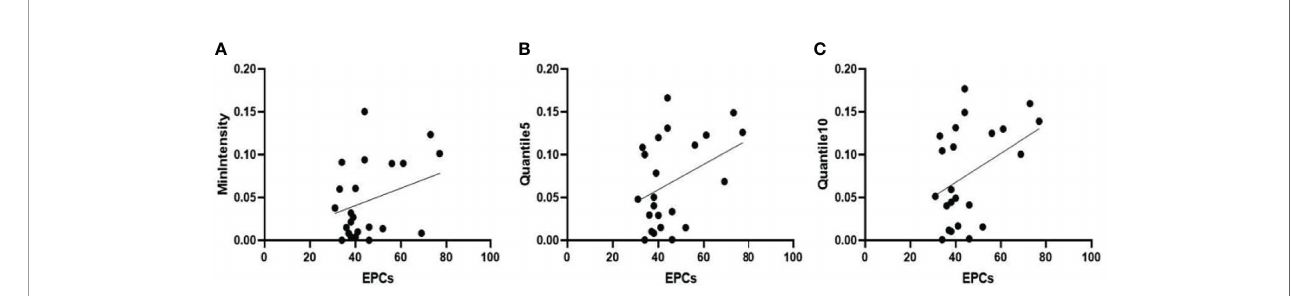
FIGURE 9 | Three weeks after successfully establishing the critical limb ischaemia model in diabetic rabbits, endothelial progenitor cell counts (EPCs) are positively correlated with the texture parameters (A) MinIntensity, (B) Quantile5, and (C) Quantile10 of the affected limb ’ s lateral